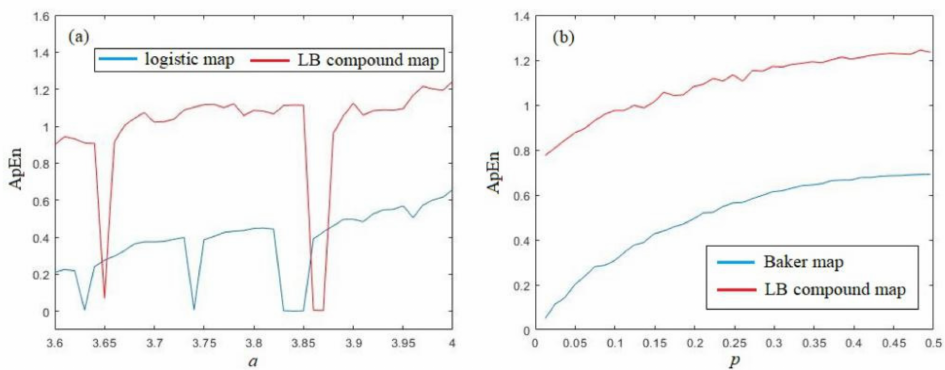
Figure 6. ApEn analysis of the LB compound chaotic map: ( a ) ApEn comaprison with logistic map ( b ) ApEn comparison with Baker map.